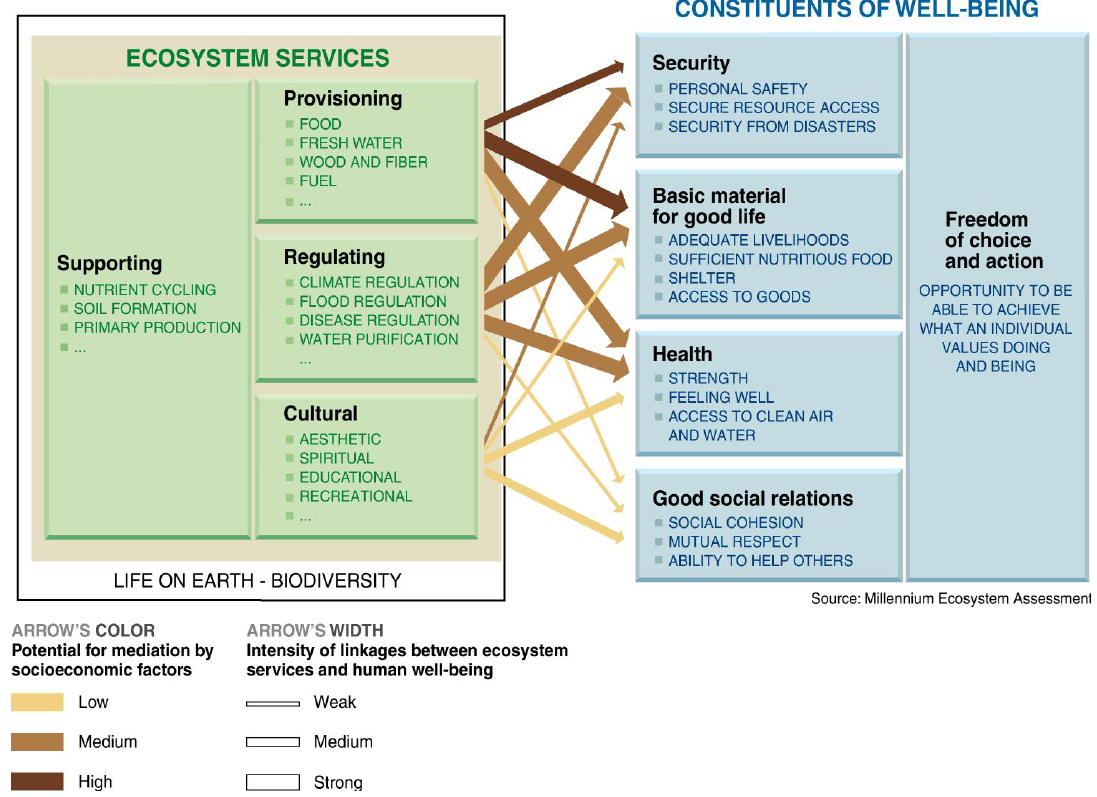
Figure A2.3. Integrated Assessment of Ecosystem Services (IAES)